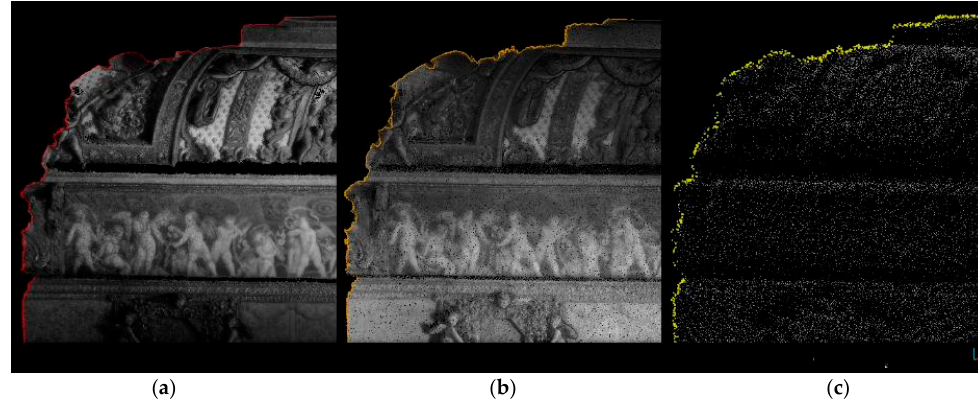
Figure 14. The benchmarking analysis on multisensors’ data of Fleur-de-lis Chamber in the Valentino Castle. ( a ) SfM points cloud; ( b ) LiDAR points cloud; and ( c ) ZEB points cloud.